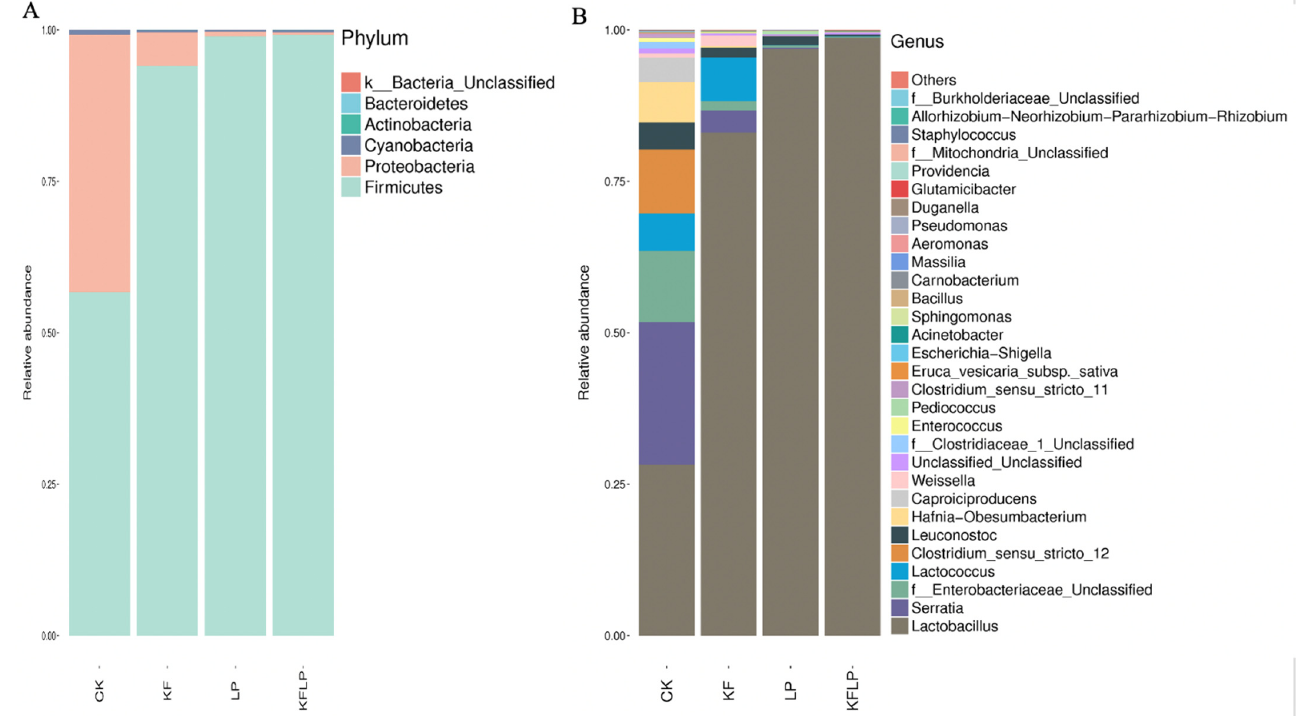
Figure 2. The bacterial community and abundances at the phylum ( A ) and genus ( B ) levels in forage rape silages. CK: the control; KF: konjac flour; LP: Lactiplantibacillus plantarum ; KFLP: konjac flour + Lactiplantibacillus plantarum